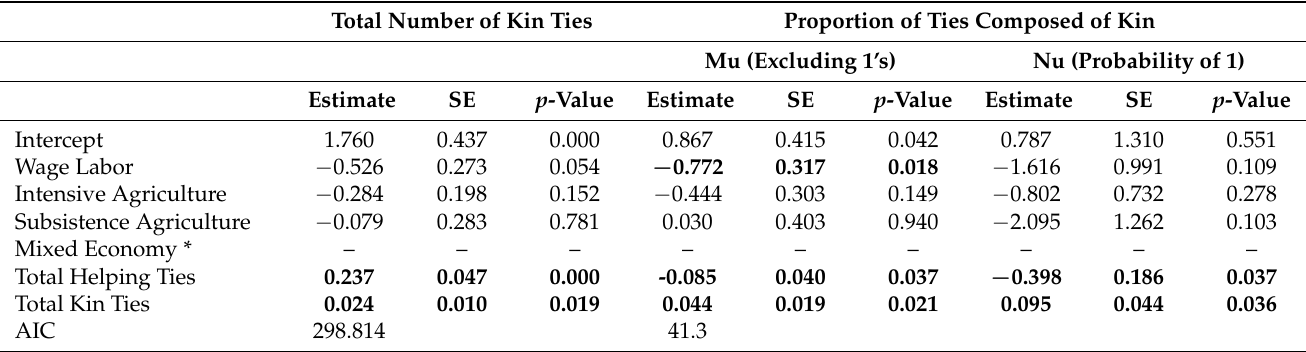
Table 3. Regression Models of Kin Support Ties.